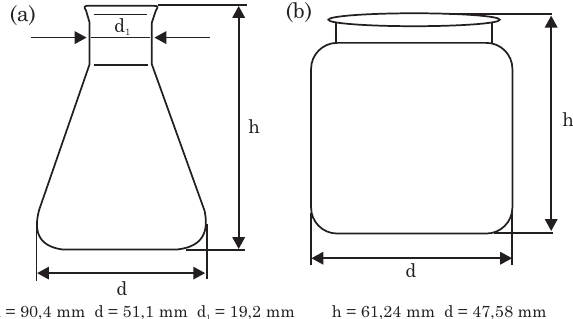
Figura 1. Dimensões dos frascos de 50 mL utilizados no estudo: a) erlenmeyer e b)